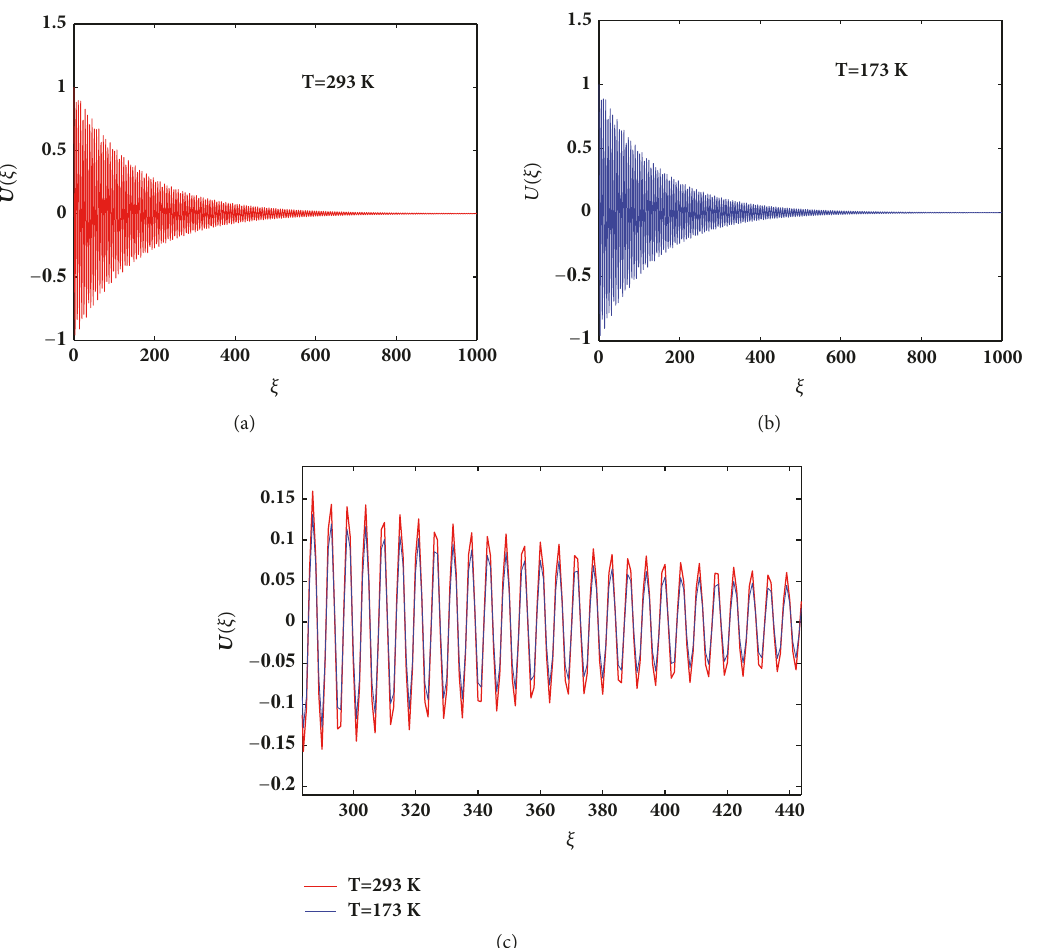
Figure 13: The curve of 𝑈(𝜉) at the temperatures(a) 𝑇 = 293 𝐾 and (b) 𝑇 = 173 𝐾 for perturbation parameter 𝜀 = 5×10 −8 . (c) The difference of the solution at different